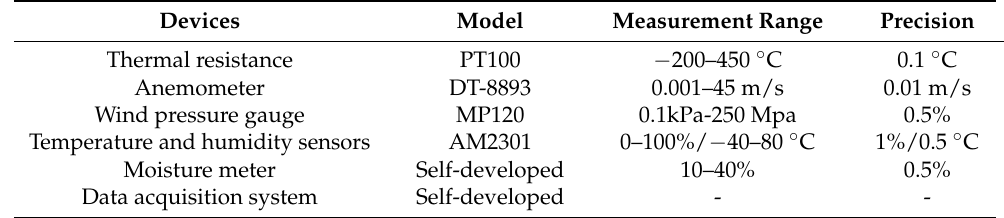
( b ) Figure 2. The scene graphs of the HE and the 3D model of the HE: ( a ) scene graph of HE; ( b ) 3D model of HE.